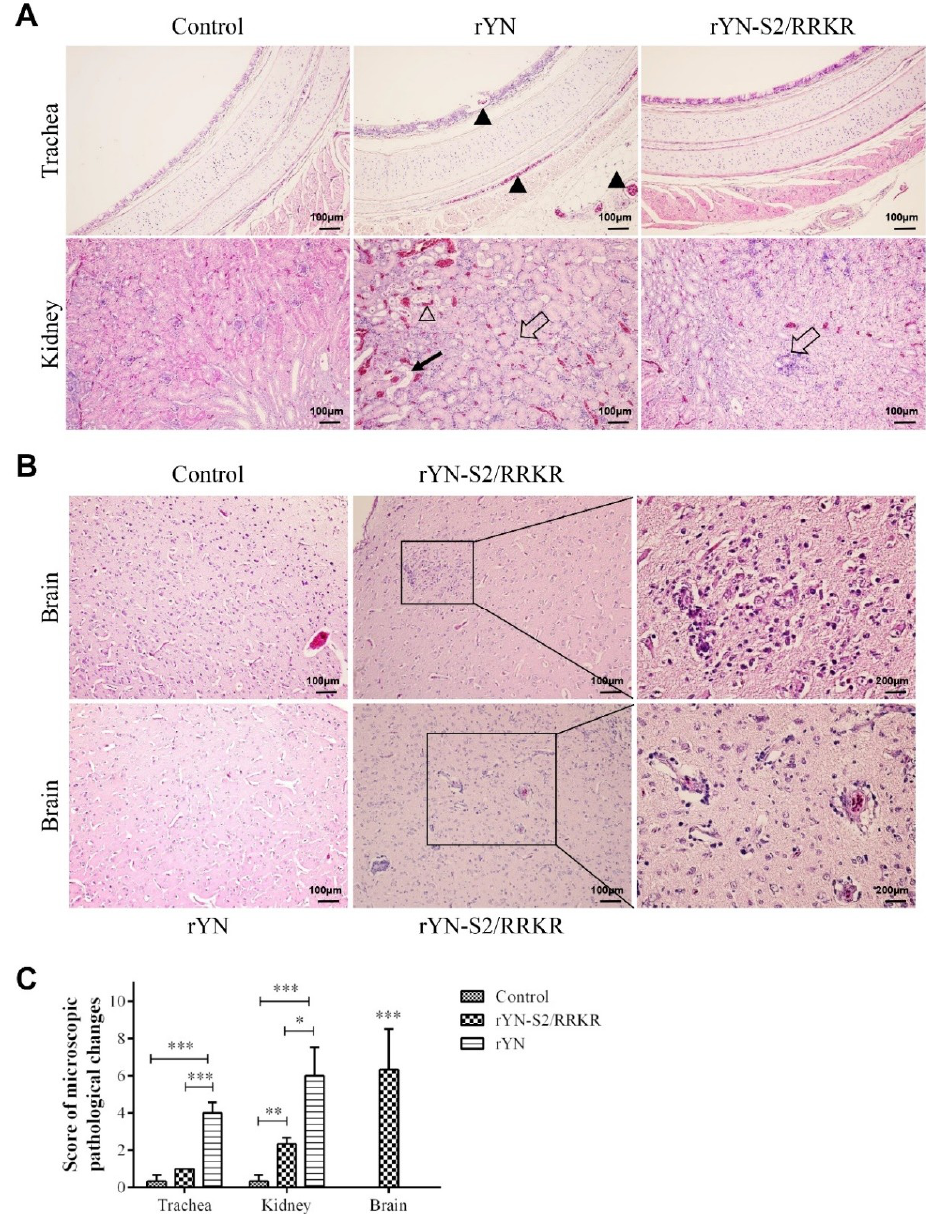
Figure 4. Microscopic lesions were observed in tissues of 3-week-old SPF chicks. ( A ) Clear lesions could be observed in the trachea and kidney in the rYN group. The black triangles indicate hemorrhage in mucosa and serosa in trachea. The blank triangle indicates hemorrhage in kidney interstitium. The black arrow indicates the cellular cast in kidney and the blank arrows indicate inflammatory cell infiltration in kidney interstitium. ( B , Results of H&E-stained brain sections from the rYN-S2/RRKR group. The panel indicates substantial microglial hyperplasia in the brain (top). The panel indicates the formation of perivascular inflammatory infiltrates at a lower level than that in 1-day-old chickens (bottom). ( C ) Scores of the 3-week-old chicken group. Sections stained with H&E were evaluated and the scores from 0 to 10, reflecting the severity of the lesions, were recorded. The indications for the scores were as follows: 0 = no microscopic lesions, 1–3 = mild lesions, 4–6 = moderate lesions and 7–10 = severe and extensive lesions. rYN-S2/RRKR caused mild injury in the respiratory and urinary systems of 3-week-old chicks compared with rYN, but still caused severe injury in the CNS (n = 4).